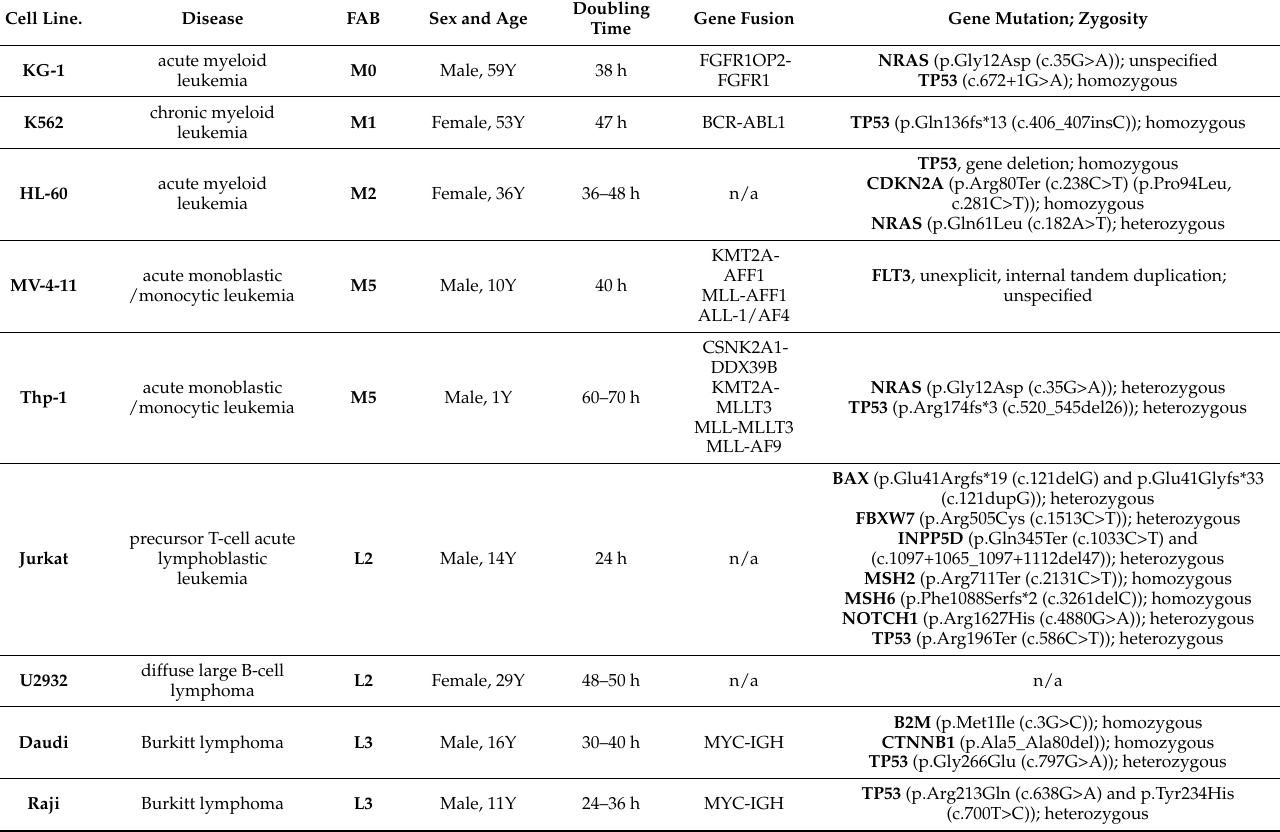
Table 1. Characterization of tested human leukemia and lymphoma